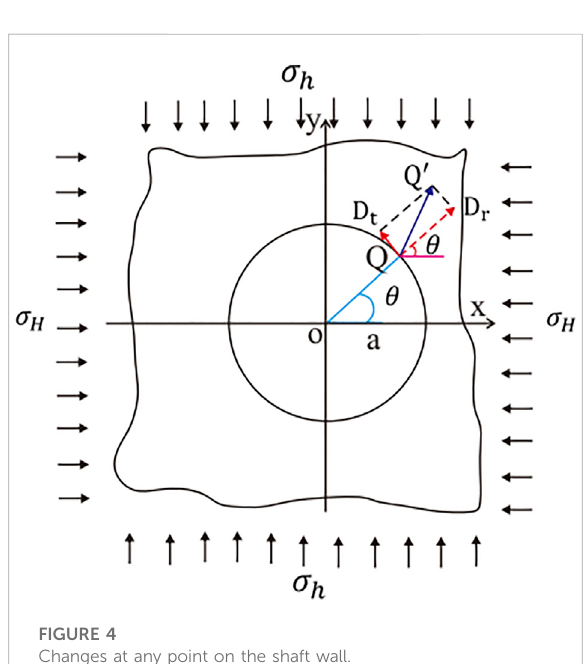
FIGURE 4 Changes at any point on the shaft